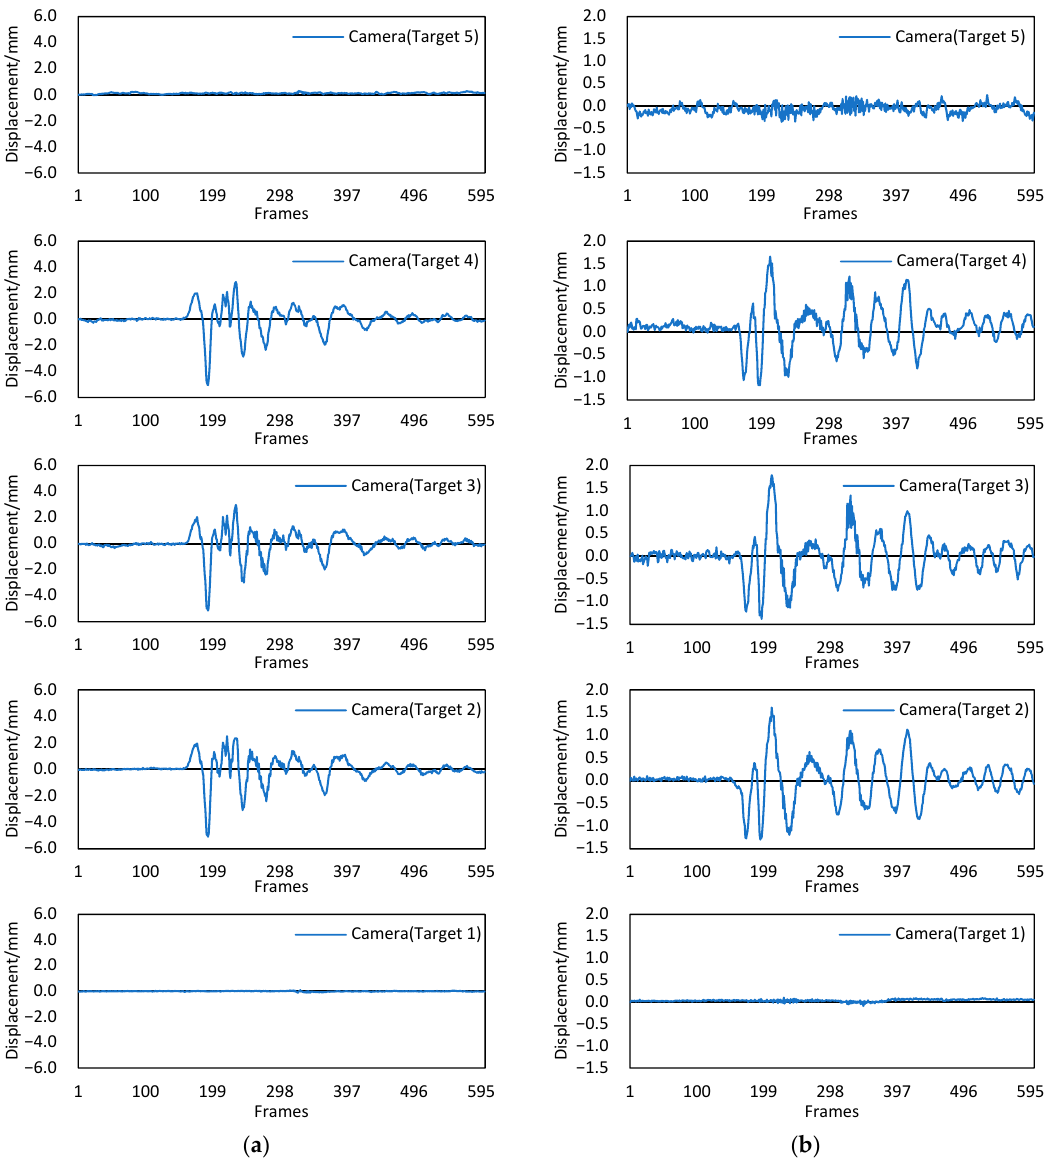
Figure 16. Dynamic displacements from 5 targets. ( a ) Displacements along the 𝑥 direction. ( b ) Displacements along the 𝑦 direction.